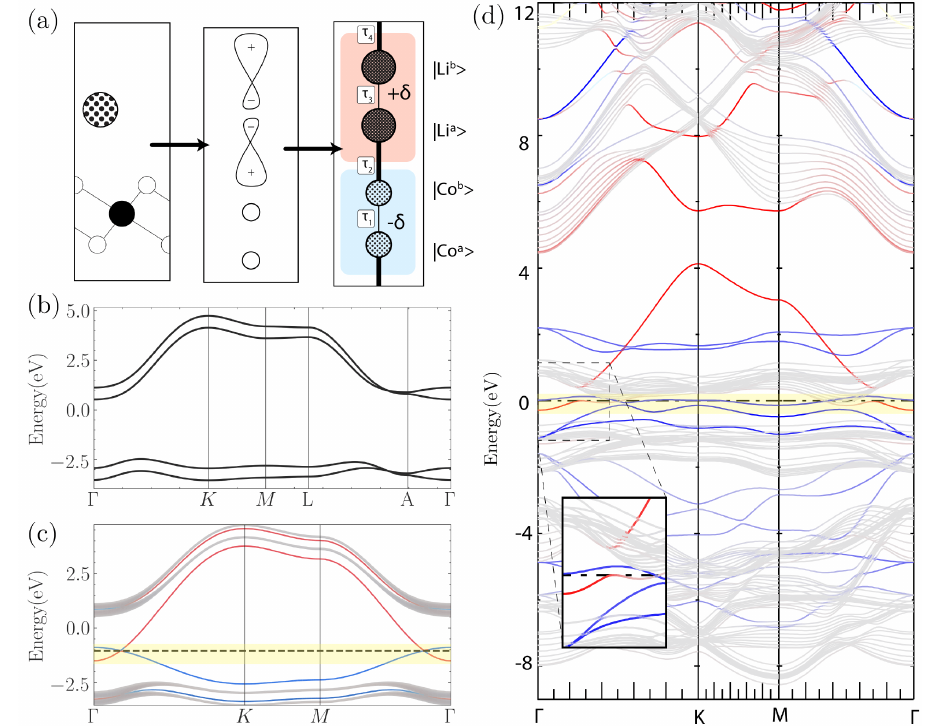
Figure 2: a) LiCoO unit cell, 1D-TB model; b) Bulk band structure of 3D Hamilto- 2 nian; c) Band structure of finite slab red Li surface, blue opposite surface CoO DFT band structure of 14nm slab. (Inset shows surface states near Fermi